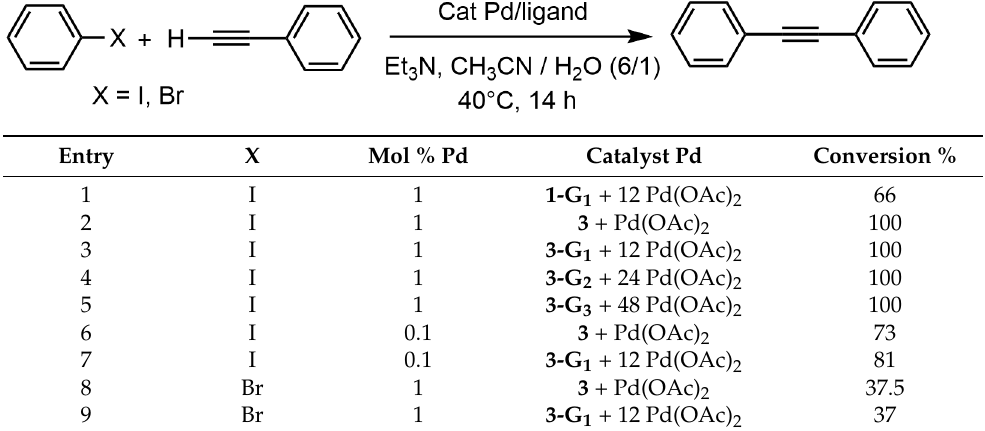
Table 4. Catalysis of Sonogashira couplings between iodo- or bromo-benzene and phenylacetylene, at 40 ◦ C.